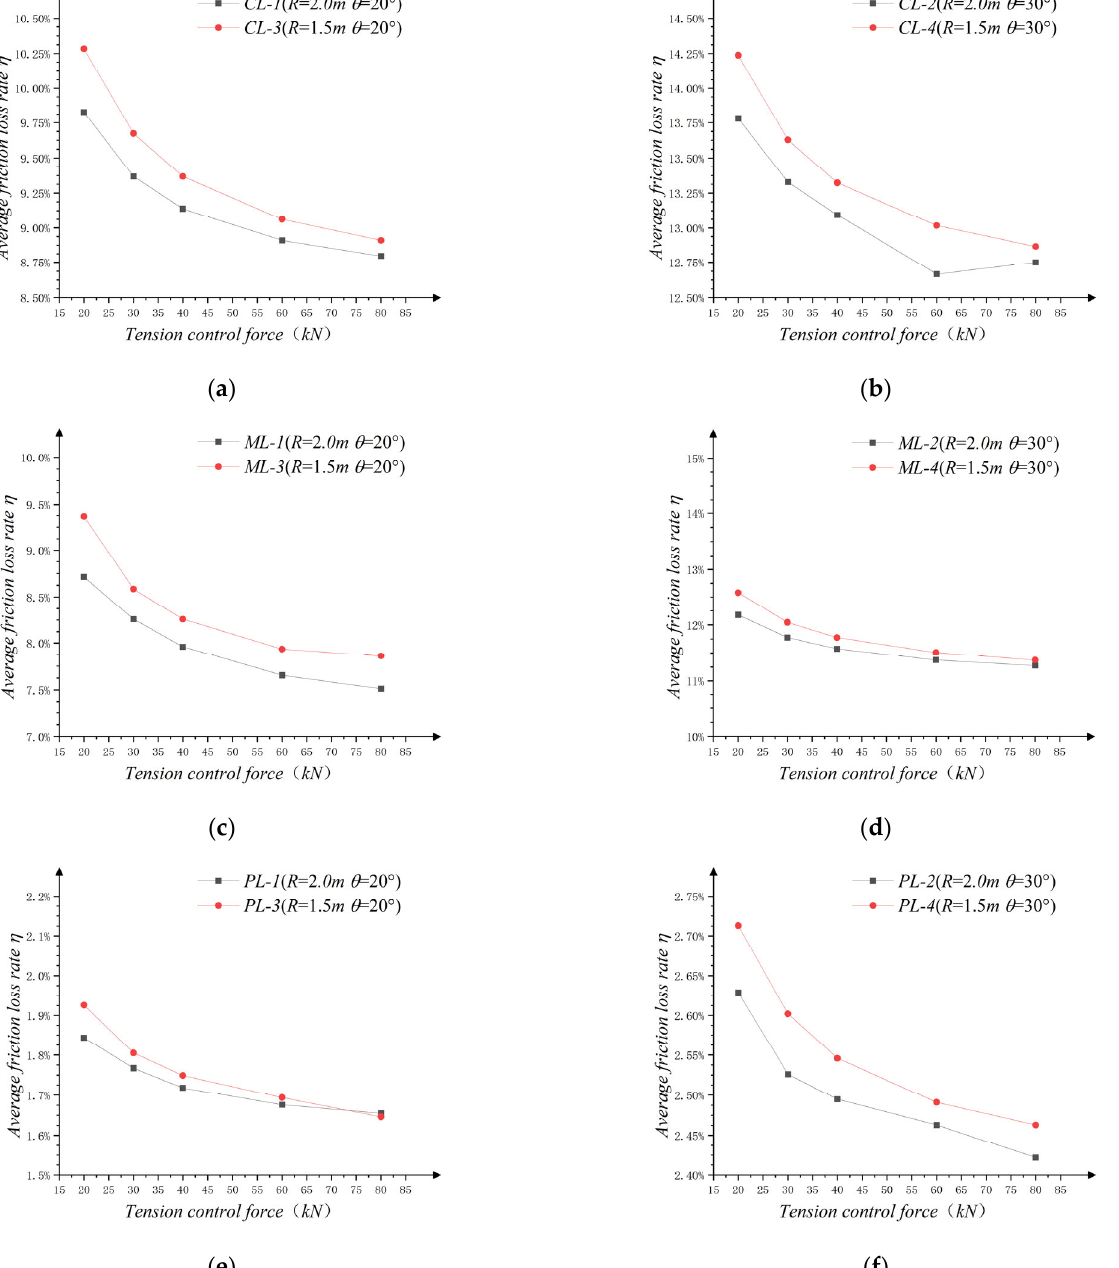
Figure 7. Comparison of data with different radius of curvature R only: ( a ) comparison group of CL ‐ 1 and CL ‐ 3; ( b ) comparison group of CL ‐ 2 and CL ‐ 4; ( c ) comparison group of ML ‐ 1 and ML ‐ 3; ( d ) comparison group of ML ‐ 2 and ML ‐ 4; ( e ) comparison group of PL ‐ 1 and PL ‐ 3; ( f ) comparison group of PL ‐ 2 and PL ‐ 4.